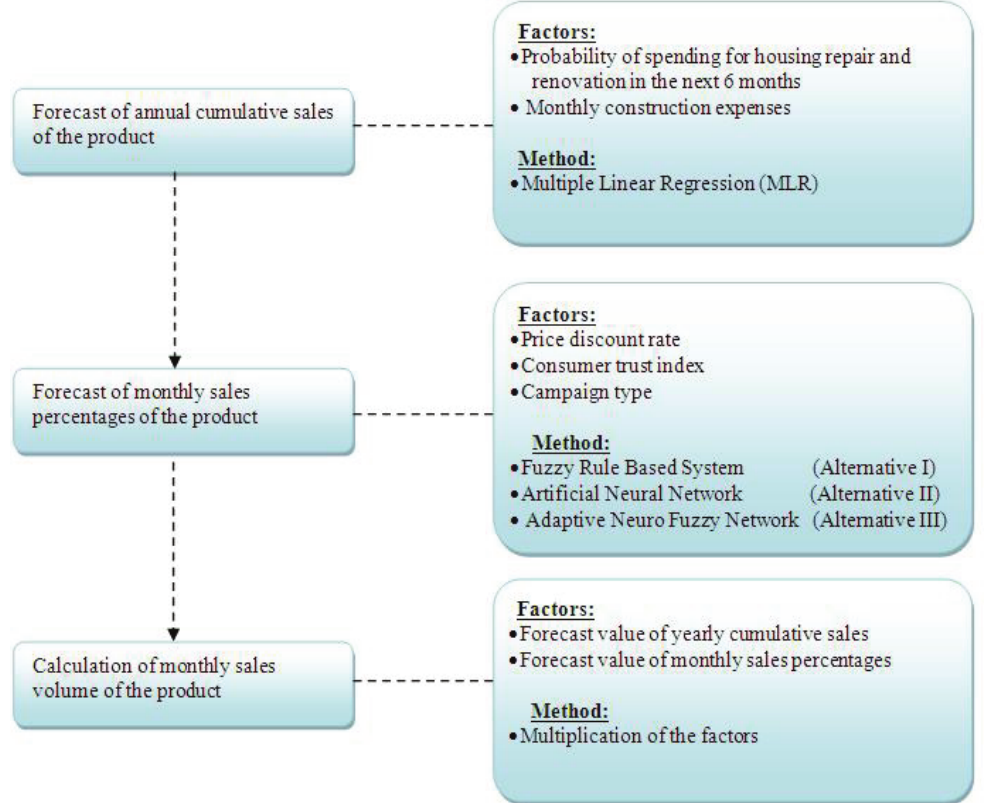
Fig. 2. The proposed hybrid forecasting